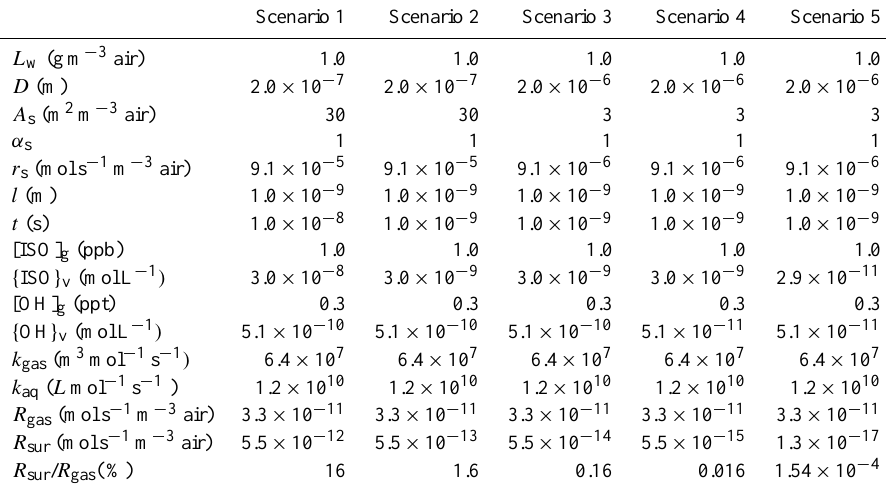
Table 1. Several scenarios about the oxidation rates of isoprene by OH radical on the surface of droplets in 1m 3 air and a comparison with the corresponding gas phase